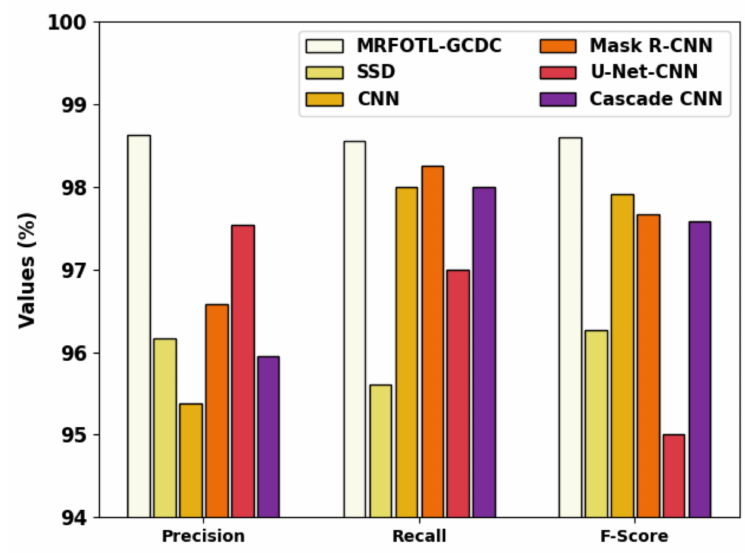
Figure 13. Comparative analysis of MRFOTL-GCDC system with other existing